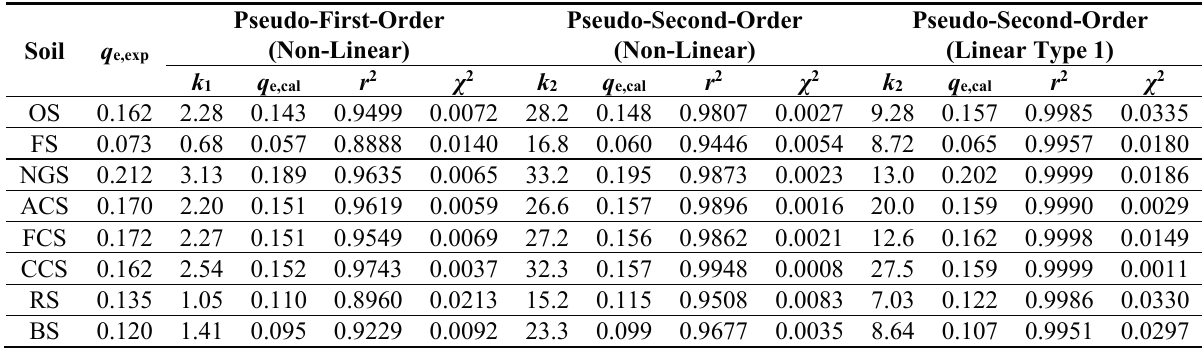
Table 2. Comparison of parameters obtained with different kinetic